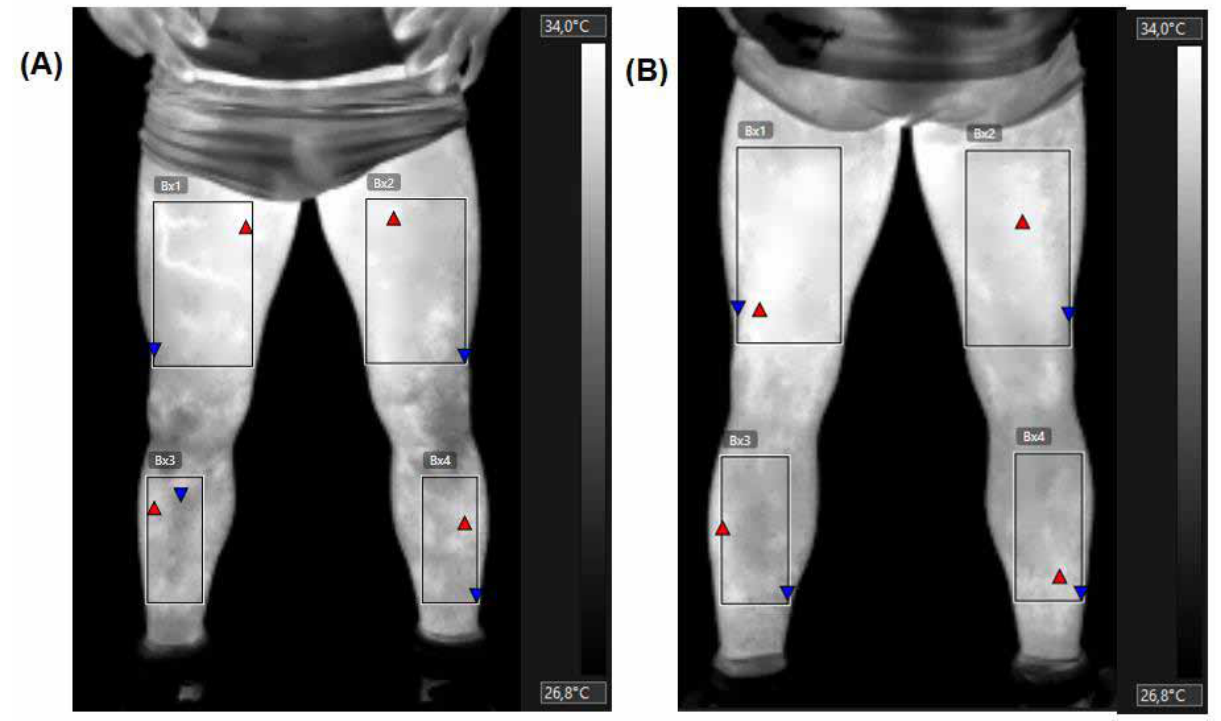
Figure 1. Thermal images anterior (A) and posterior (B) views from thighs and legs.